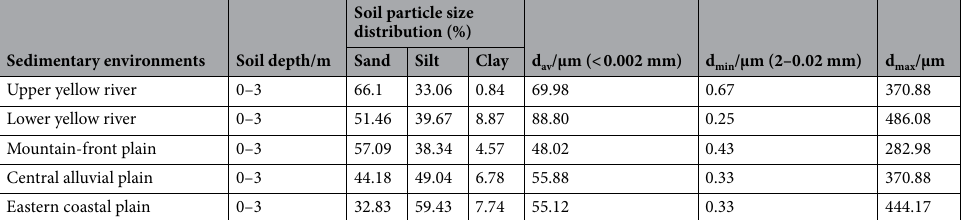
Table 2. Composition of soil texture particles under different sedimentary environments.